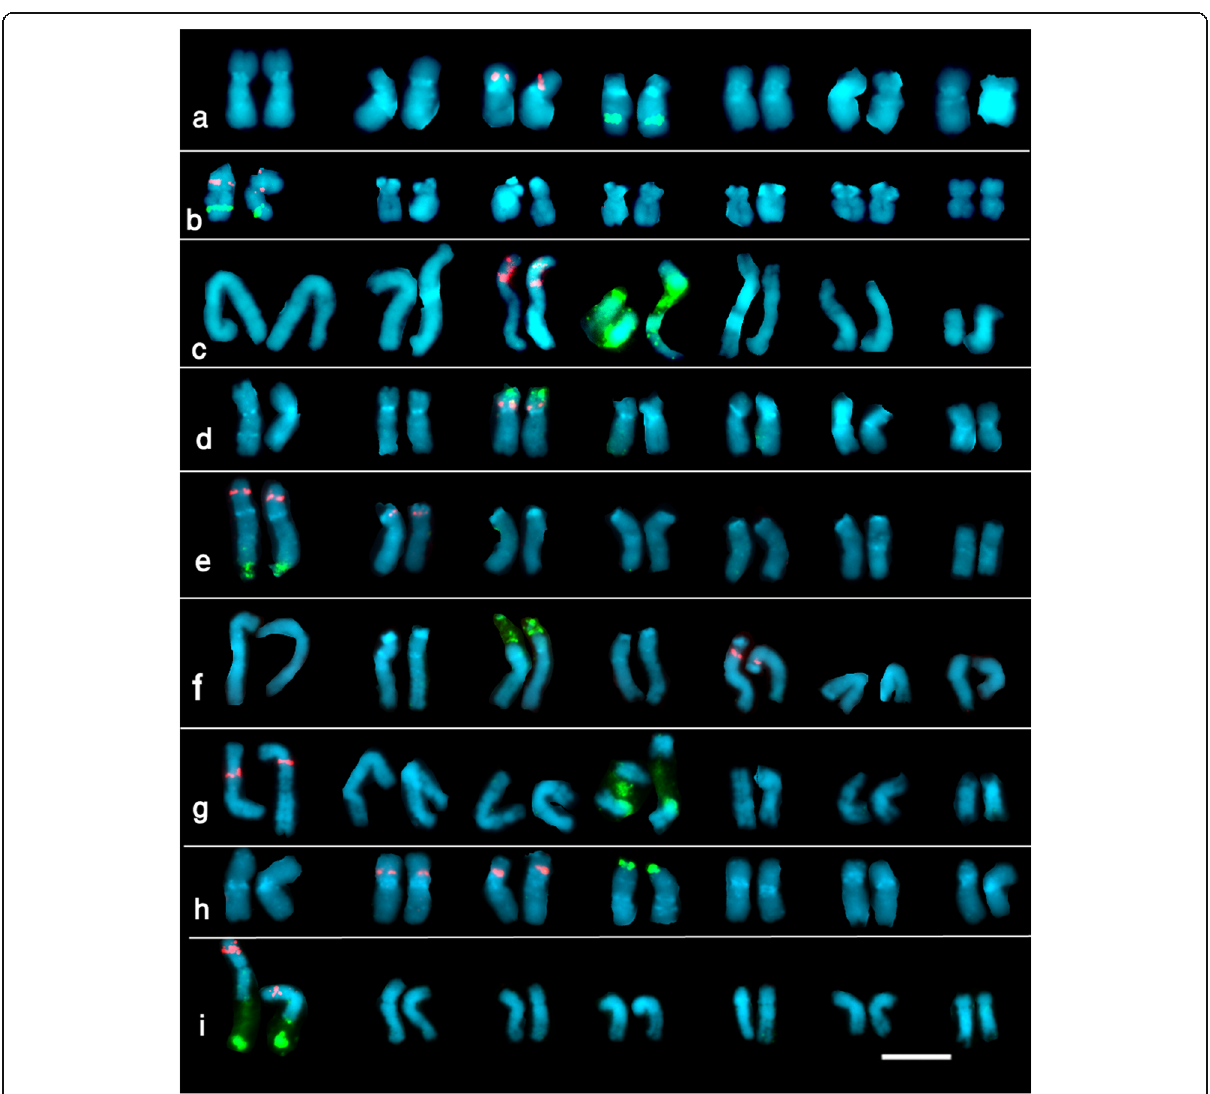
Fig. 2 The Karyotypes of the examined Lathyrus species with 5S rDNA (in red) and 45S rDNA (in green) Bar = 5 μ . a ) L. paranensis Burkart b ) L. nissolia L. c ) L. odoratus L. d ) L. hirsutus L. e ) L. amphicarpos L. f ) L. gorgoni Parl. g ) L. articulatus L. h ) L. sphaericus Retz i ) L. incospicuus